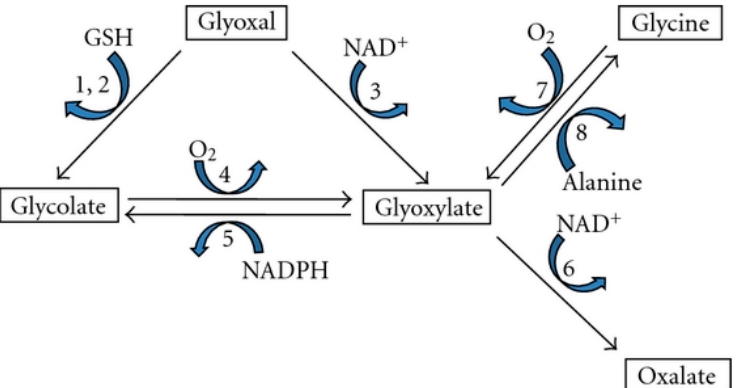
Figure 2. Oxalate synthesis pathway from glyoxal. In this mechanism, enzymes: alanine: glyoxylate and aminotransferase are active. (1) glyoxylase I, (2) glyoxylase II, (3) aldehyde dehydrogenase, (4) glycolate oxidase, (5) glyoxylate reductase, (6) lactate dehydrogenase, (7) D-amino acid oxidase and (8) alanine: glyoxylate aminotransferase.